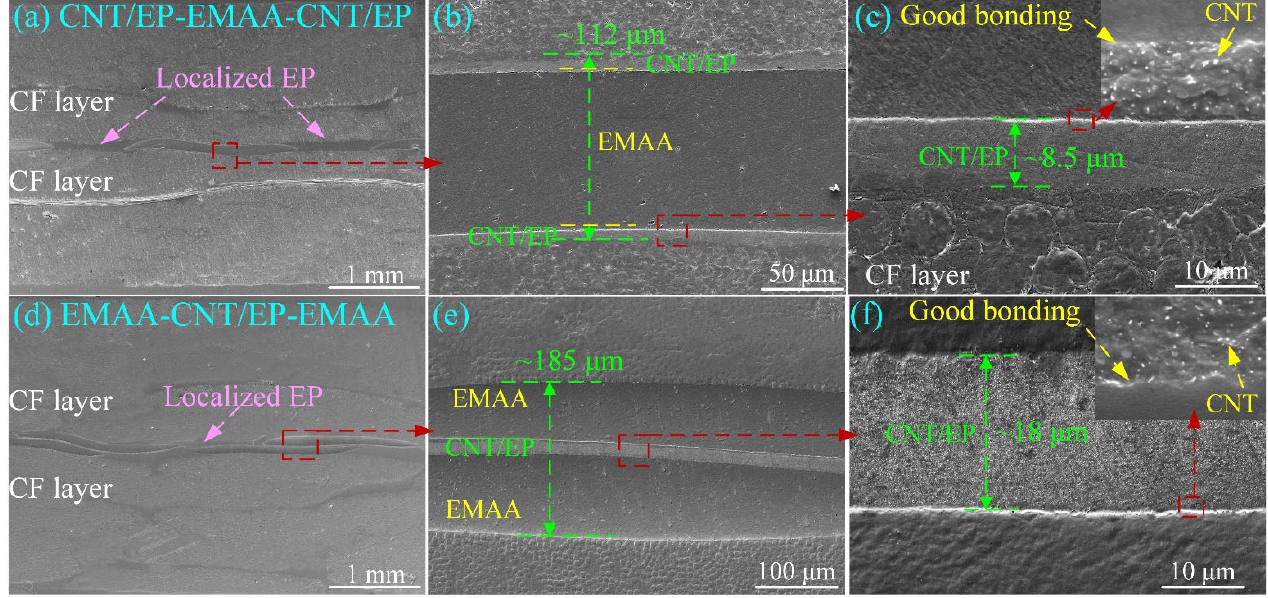
Figure 4. FESEM images of cured laminates, ( a – c ) CFRP with the CNT/EP ‐ EMAA ‐ CNT/EP interleaf, ( d – f ) CFRP with the EMAA ‐ CNT/EP ‐ EMAA interleaf.